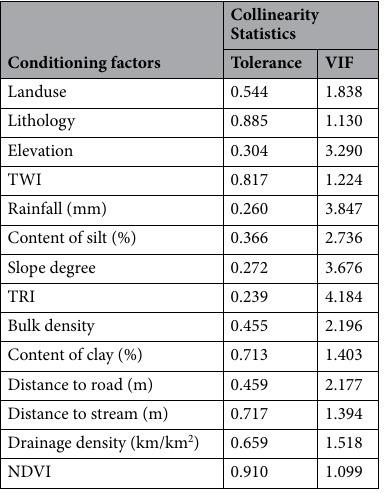
Table 1. Multi-Collinearity analysis of the gully conditioning factors.